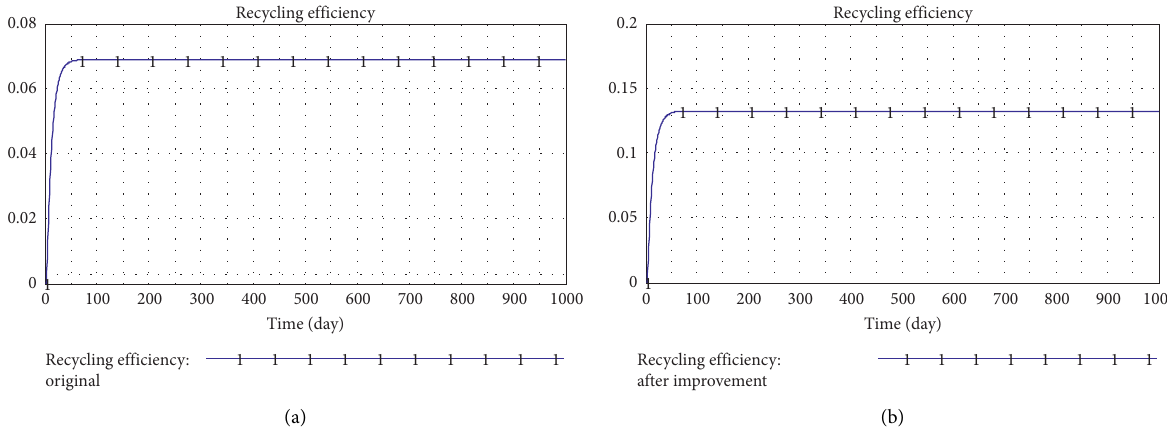
Figure 6: Comparison of recycling efficiency between (a) the original model and (b) the improved